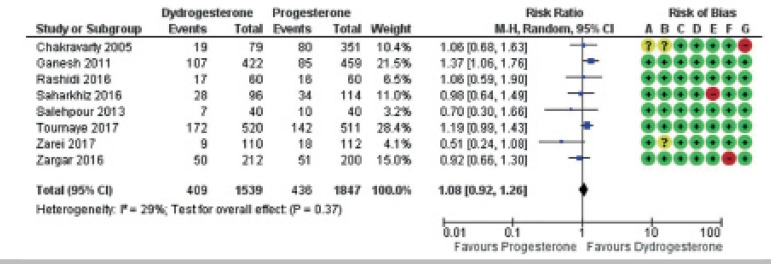
Forest plot for live birth/ongoing pregnancy. Risk of bias legend: A
= Selection bias (random sequence generation); B = Selection bias
(allocation concealment); C = Performance bias; D = Detection bias;
E = Attrition bias; F = Reporting bias; G = Other biases.